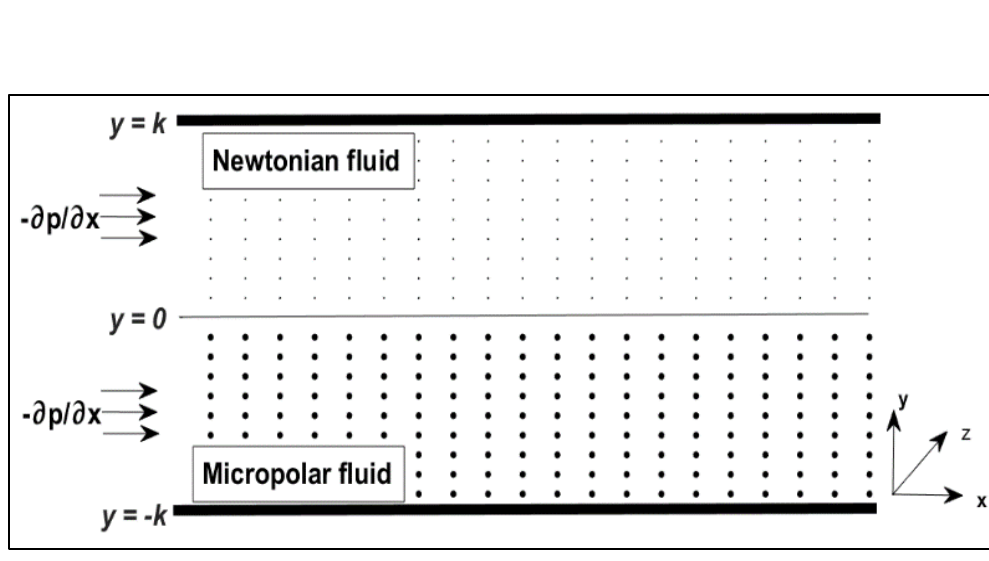
Figure 1. The geometrical configuration of the mean flow of two immiscible